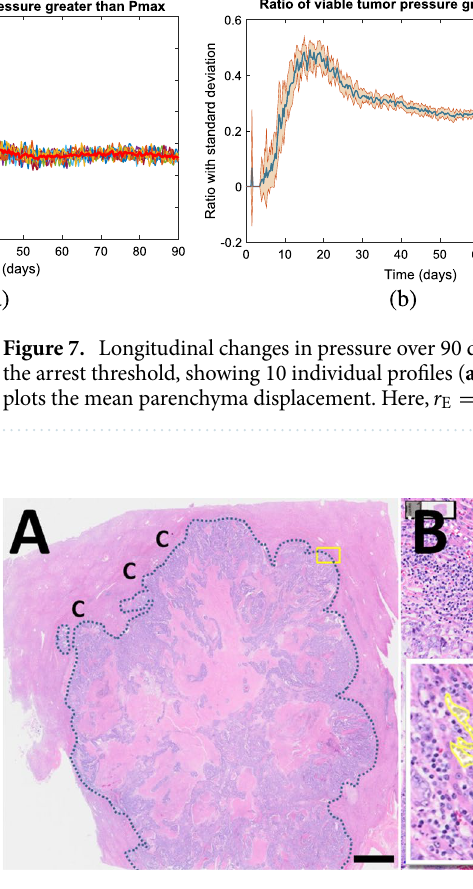
Figure 8. Colorectal cancer metastasis in human liver: A Hematoxylin and eosin (H&E) stained whole slide image of a CRC metastasis in liver. Note the deformed liver parenchyma (C) near the tumor-parenchyma boundary (dashed line), which indicates sufficient tissue deformation (strain) to be observed macroscopically. Scale bar: 2 mm. B Magnified view of the yellow box from A near the tumor boundary. Note that the regular liver microstructure has been deformed (strained) to be highly anisotropic, indicating compression in the direction orthogonal to the tumor boundary (dashed line) and potential stretching in the direction parallel to the boundary. This deformation is greatest near the tumor (C) and decreases farther from the tumor boundary (C*). The yellow highlighted cells in the inset show tumor cells growing along paths of mechanical least resistance in collapsed sinusoids. Scale bar: 100 µ m